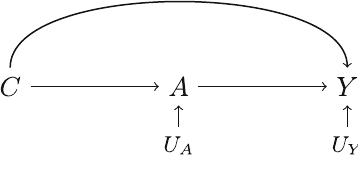
Figure 1: A simple DAG with variables relevant to Y E a [ ]